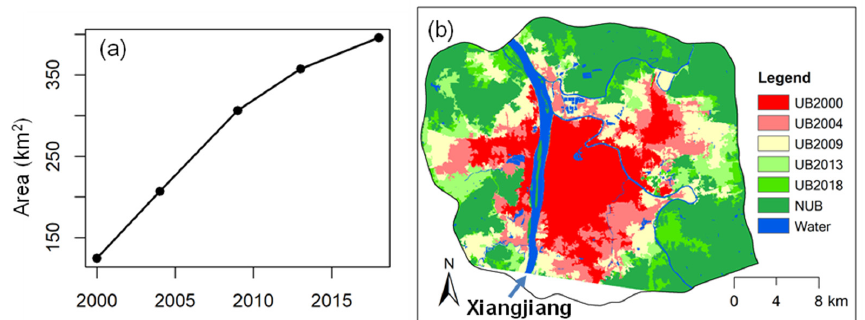
Figure 5. Urban area increase from 2000 to 2018 ( a ), and spatial distribution of urban expansion ( b ). (UB 2000: urban area before 2000; UB 2004: area urbanized between 2000 and 2004; UB 2009: area urbanized between 2004 and 2009; UB 2013: area urbanized between 2009 and 2013; UB 2018: area urbanized between 2013 and 2018; NUB: non-urban (natural) land in